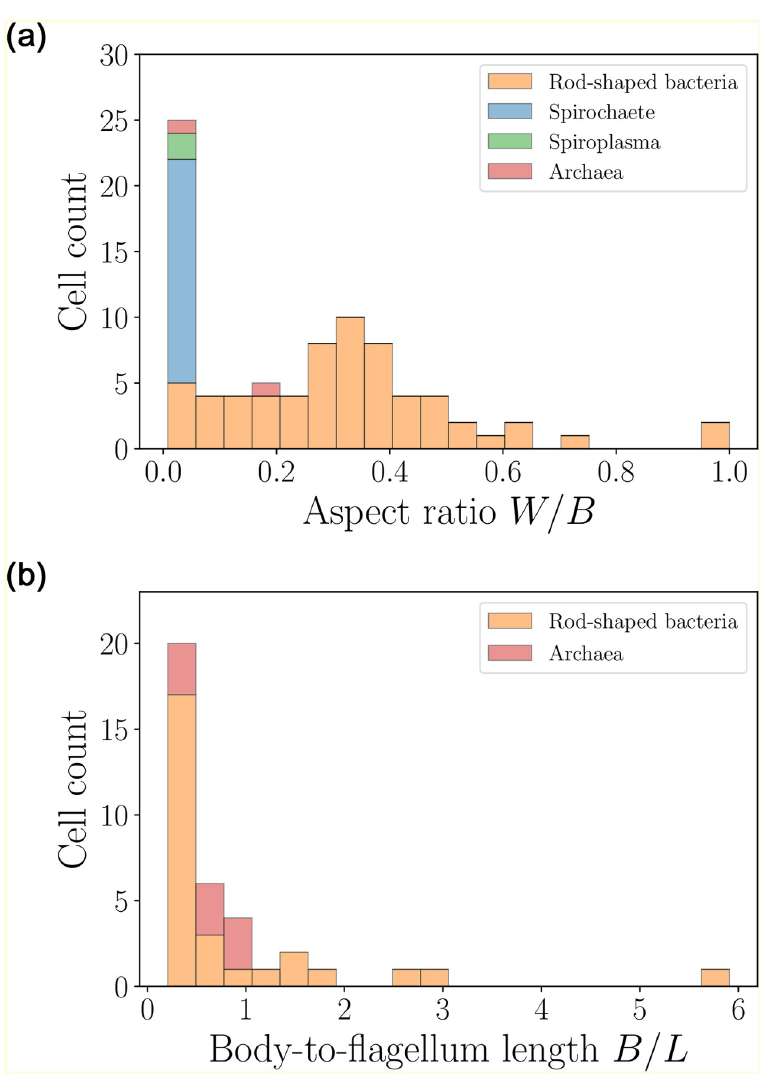
Fig 5. Histograms of aspect ratios W / B (left) and body-to-flagellum length B / L (right) for rod-shaped bacteria (excluding spirochaetes and Spiroplasma ) ( h W / B i = 0.33 ± 0.20 ( n = 63), h B / L i = 0.93 ± 1.19 ( n = 28)), spirochaetes ( h W / B i = 0.02 ± 0.01 ( n = 17)), Spiroplasma ( h W / B i = 0.03 ± 0.00 ( n = 2)) and archaea ( h W / B i = 0.11 ± 0.06 ( n = 2), h B / L i = 0.63 ± 0.24 ( n = 9)). All bacteria in our study are prolate, with an average aspect ratio h W / B i = 0.25 ± 0.22 ( n = 84), with a notable slenderness of spirochaetes and Spiroplasma . If the prokaryotes possess freely rotating flagella, their length often exceeds the body size h B / L i = 0.86 ± 1.05 ( n = 37) (both spirochaetes and Spiroplasma are not included in the B / L